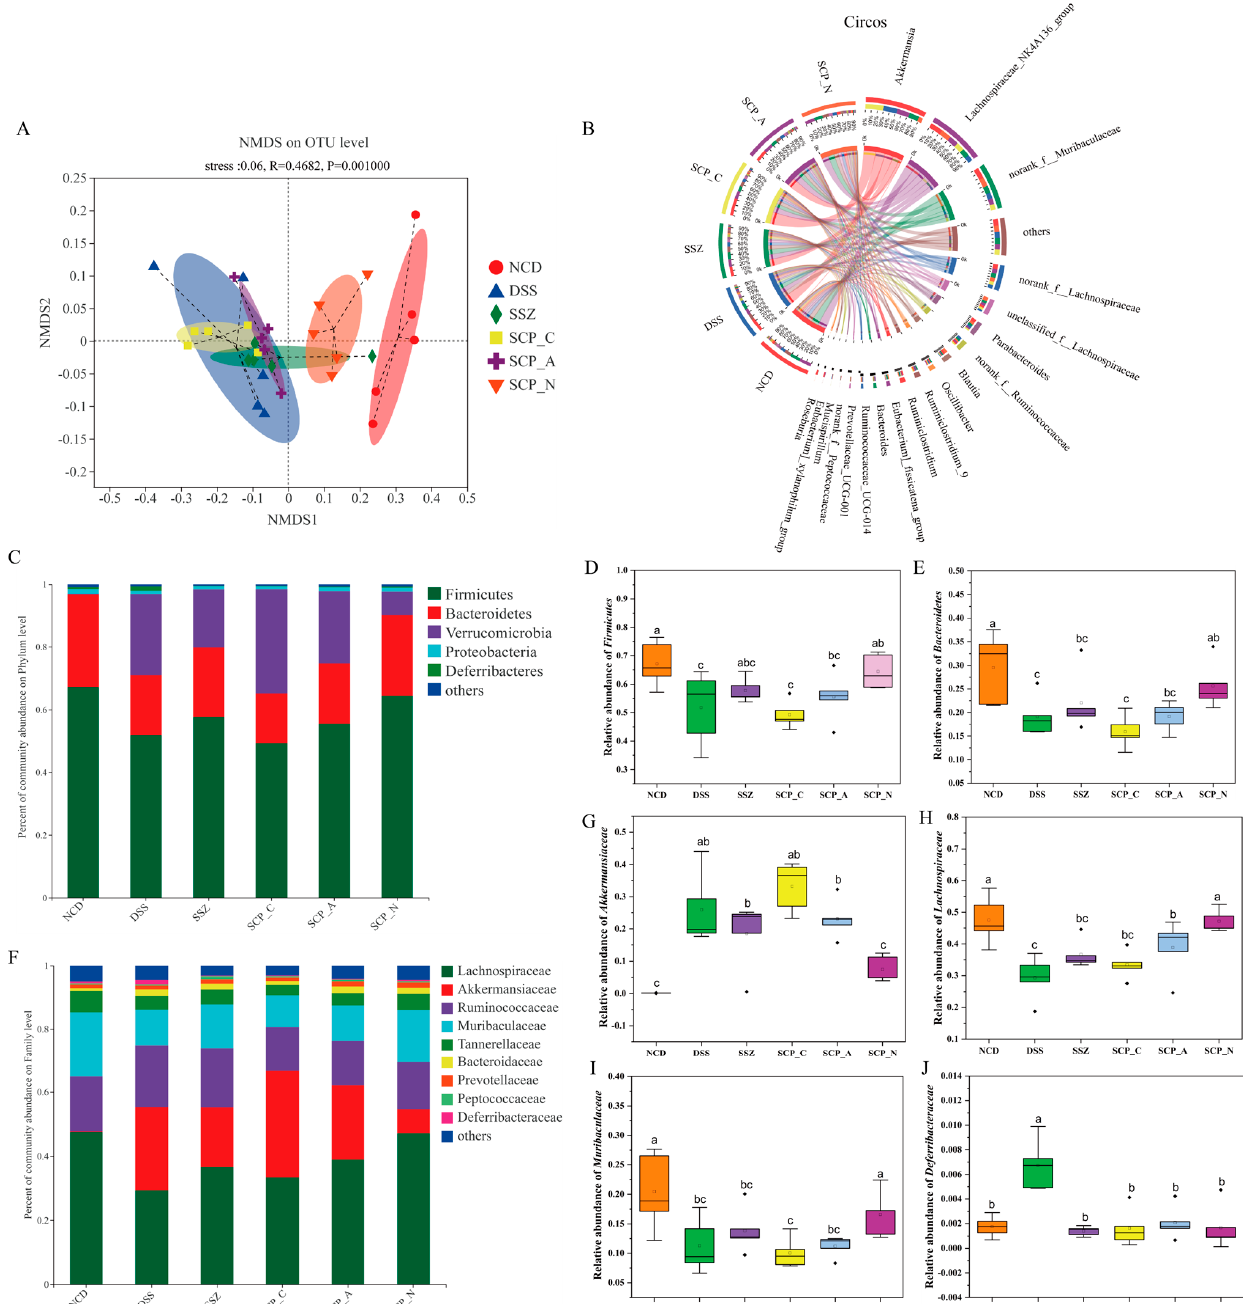
Figure 4. Effects of polysaccharide on gut microbiota composition of different groups. ( A ) NMDS score plot in OTU level; ( B ) Linear relationships between samples and species; ( C ) Bacterial taxonomic composition at the phylum level; ( D ) relative abundance of Firmicutes; ( E ) relative abundance of Bacteroidetes; ( F ) Bacterial taxonomic composition at the family level; relative abundance of ( G ) Akkermansiaceae , ( H ) Lachnospiraceae , ( I ) Muribaculaceae , and ( J ) Deferribacteraceae . Different letters (a–c) represent significant differences among groups ( p <